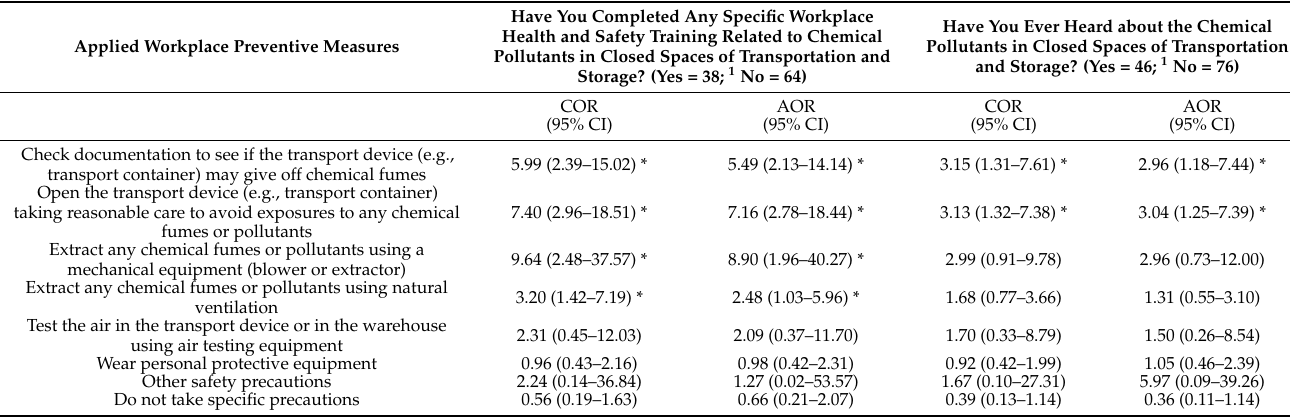
Table 8. Association of completing specific workplace health and safety training related to chemical pollutants and being aware of chemical pollutants with applying preventive measures in closed spaces of transportation and storage at logistics companies. Applied Workplace Preventive